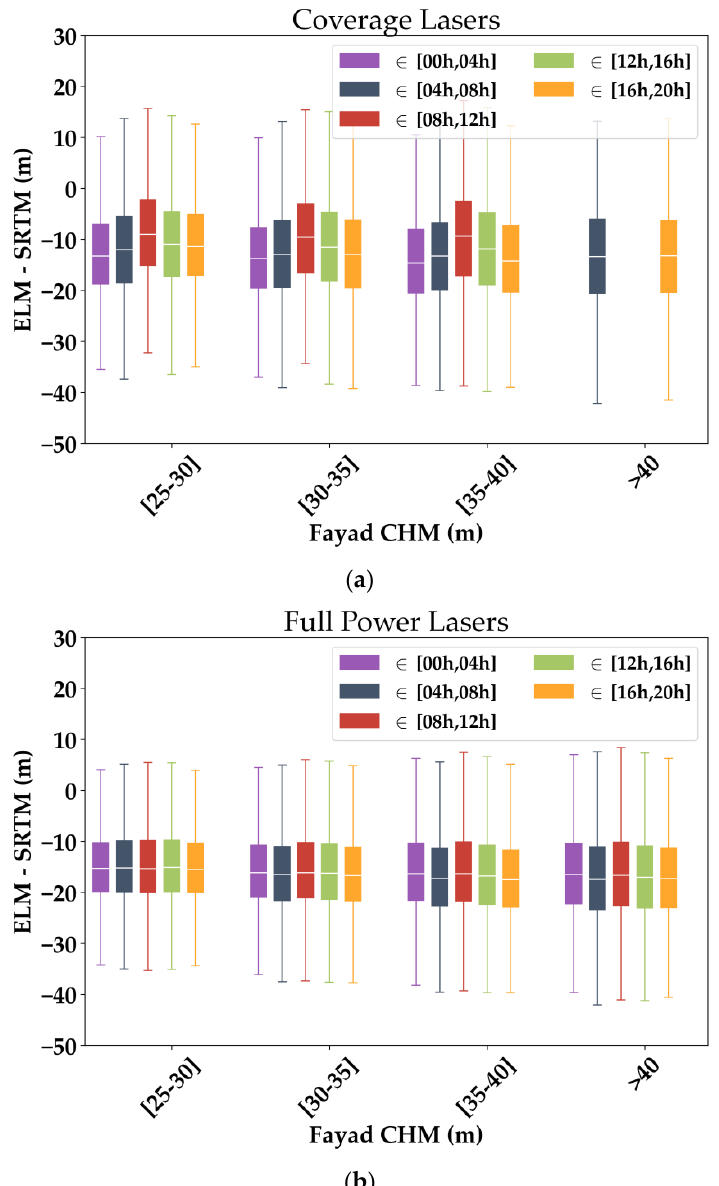
Figure 10. Boxplots of the difference between the elevation of each waveform’s lowest mode (ELM) and SRTM from GEDI’s coverage ( a ) and full-power lasers ( b ) as a function of acquisition time. Only acquisitions with beam sensitivity ≥ 98% were used. The lack of boxplots in ( a ) corresponds to the insufficiency of available data in the corresponding time ranges.